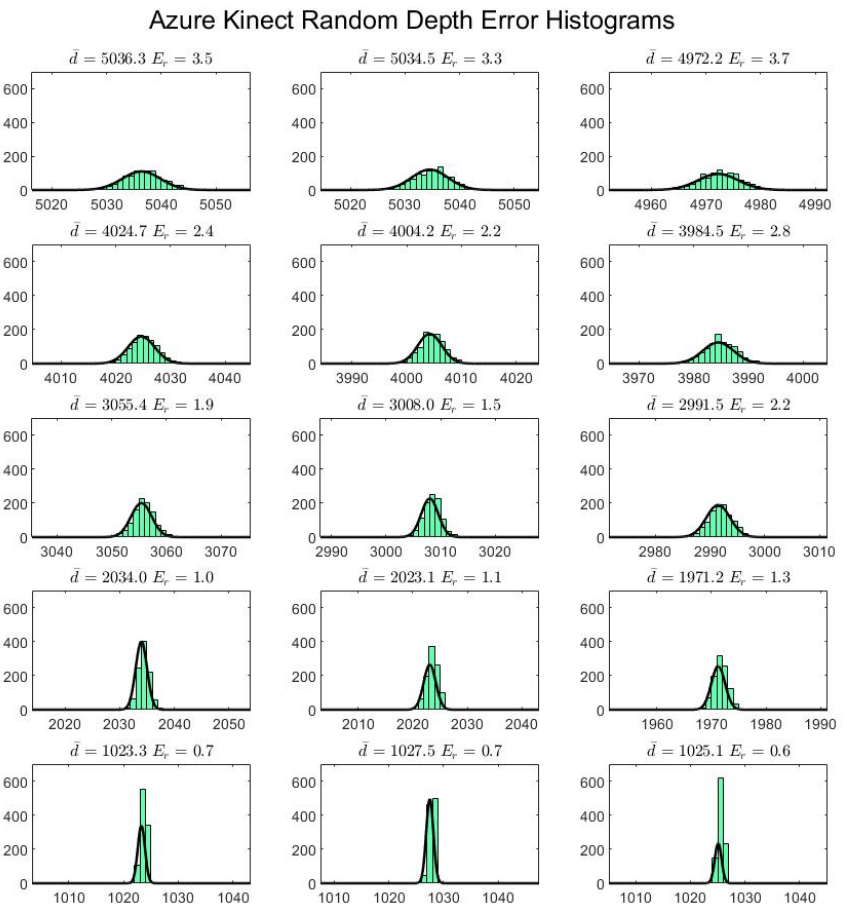
Figure 12. Random depth error for the Azure Kinect, where d indicates the average depth value and E r is the standard deviation, or the random depth error. The horizontal axes and titles are in units of millimeters, while the vertical axes indicate bin counts. Each bin is 1 mm in width. Table 2. Mean and standard deviation values of the systematic spatial error at each location for both Kinect v2 and Azure Kinect. Lowest values for a particular location are marked in